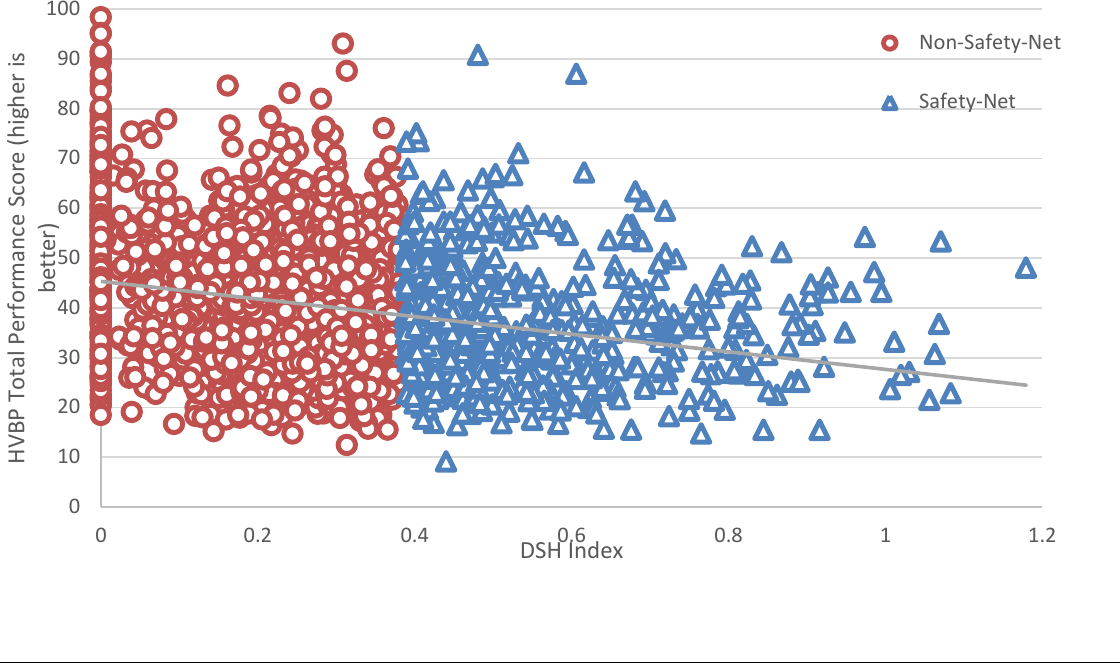
Figure 7.4. Scatterplot of DSH Index vs. FY2016 HVBP Total Performance